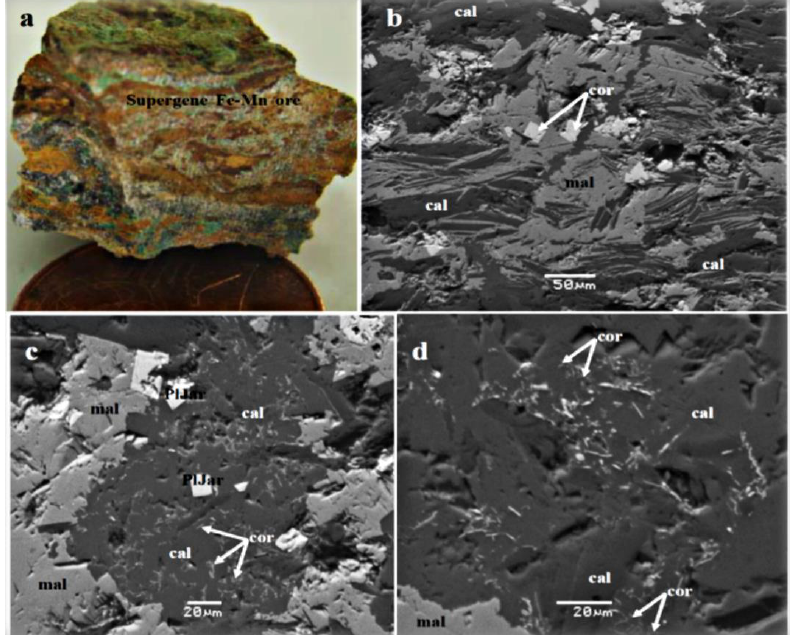
Figure 4. ( a ) Photograph of the supergene Fe-Mn ore hosted in limestone from the Grammatiko mine. ( b – d ) Representative back scattered images showing the dominant association of calcite (cal) with coronatite (cor), malachite (mal), and plumbojarosite (PlJar). The dominant Fe-hydroxide mineral at the Legrena valley mineralization is goethite. Calcite as gangue mineral is almost pure, with Mg and Fe in its crystals being insignificant. Iron-Al-Silicates are common as a component in the matrix. A replacement of Fe-ox- ides/hydroxides (light grey) by dark grey Mn-Fe hydroxides is a common feature (Figure 5). A peculiar feature of goethite is its spheroidal, bacterio-morphic shape, in an open space filling case (Figure 5c). Representative back scattered images from spherical Fe-Mn porous ore show a consortium of bacteria fossils (white arrows), including abundant sphere or coccus and filaments within a fine-grained matrix. Although the chemical com- position of those fossilized bacteria was not determined exactly, due to their very small size, they exhibit a wide chemical composition, comparable to that of Mn-Fe-hydroxides, containing significant amounts of K, Na, P, S, Ca, Mg, As, Ba and Cl (Table 1).